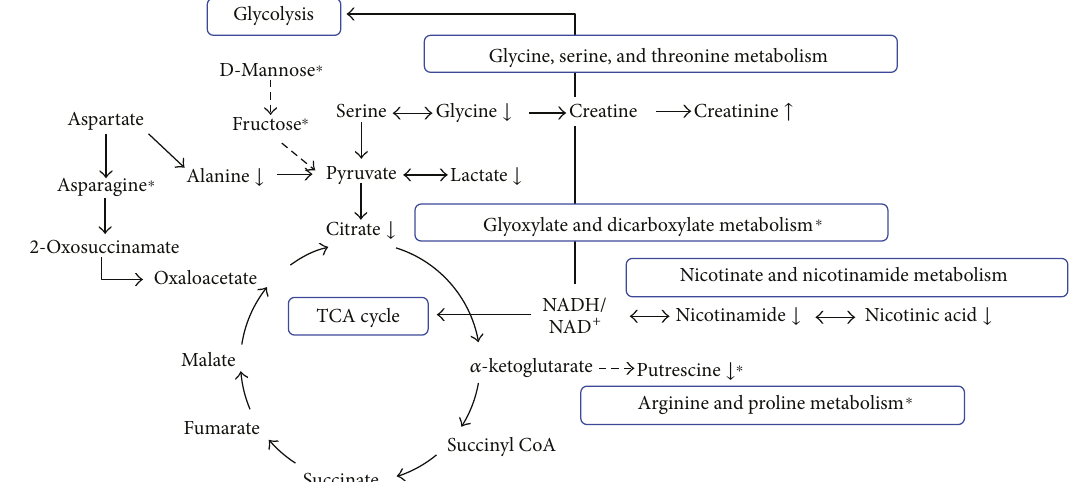
Figure 7: The energy perturbed process in response to SD exposure and CGA intervention. The levels of changed metabolites in SD group compared to BP group were labeled with ( ↓ ) downregulated or ( ↑ ) upregulated; ∗ metabolites or metabolic pathway could be regulated by CGA. Solid arrows represent direct connections, and dashed arrows represent multiple and indirect connections between two compounds. The contents of the blue box represent energy processes or metabolic